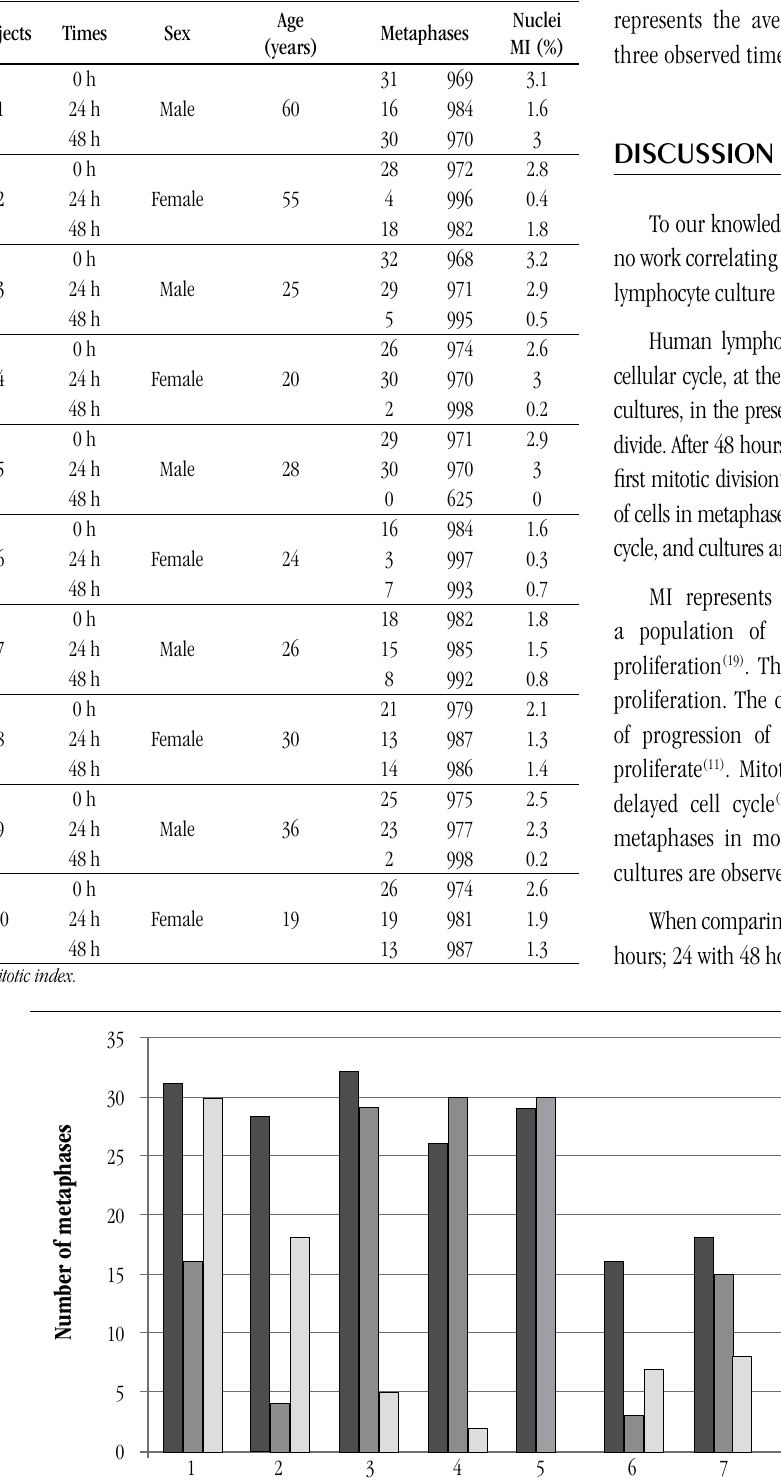
tABLE – Number of metaphases, nuclei, and mitotic index, by subject, obtained from lymphocytes cultured at times zero, 24 hours and 48 hours